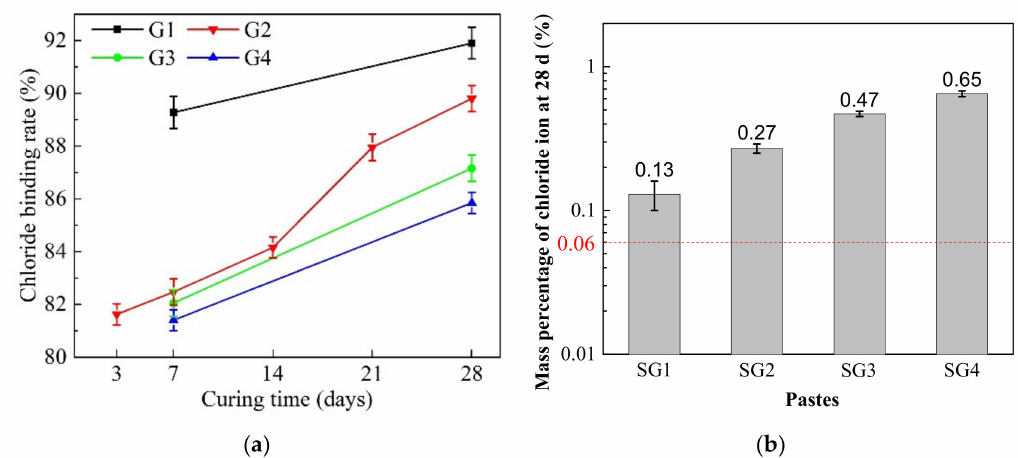
Figure 11. ( a ) Chloride binding rate of the pastes with different SR addition at different curing times; ( b ) Weight percentage of free chloride ion in the pastes.